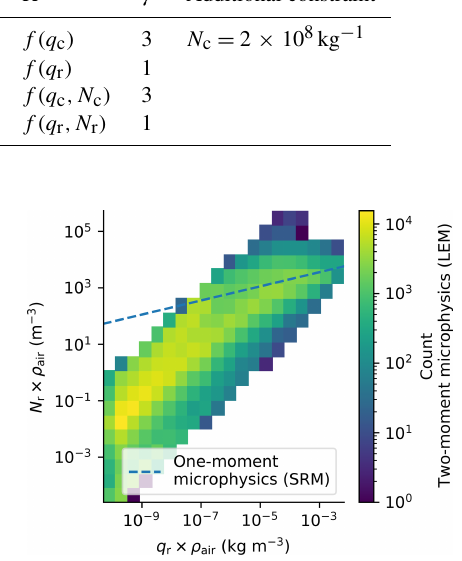
Figure 3. Relation of volumetric raindrop number concentration and mass mixing ratio for one-moment and two-moment micro-